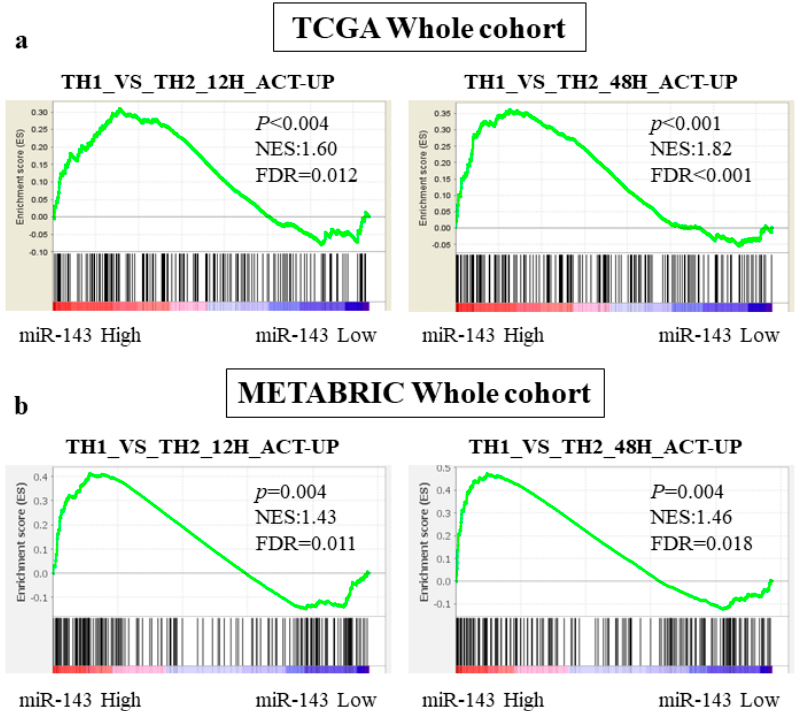
Figure 3. GSEA of whole patients in TCGA and METABRIC regarding miR-143 expression. ( a ) The association between miR-143 expression and the gene sets enrichment related to Th1 cells in TCGA; ( b ) The association between miR-143 expression and the gene sets enrichment related to Th1 cells in METBRIC cohort. Th1, Helper T cell type 1; Th2 Helper T cell type 2.